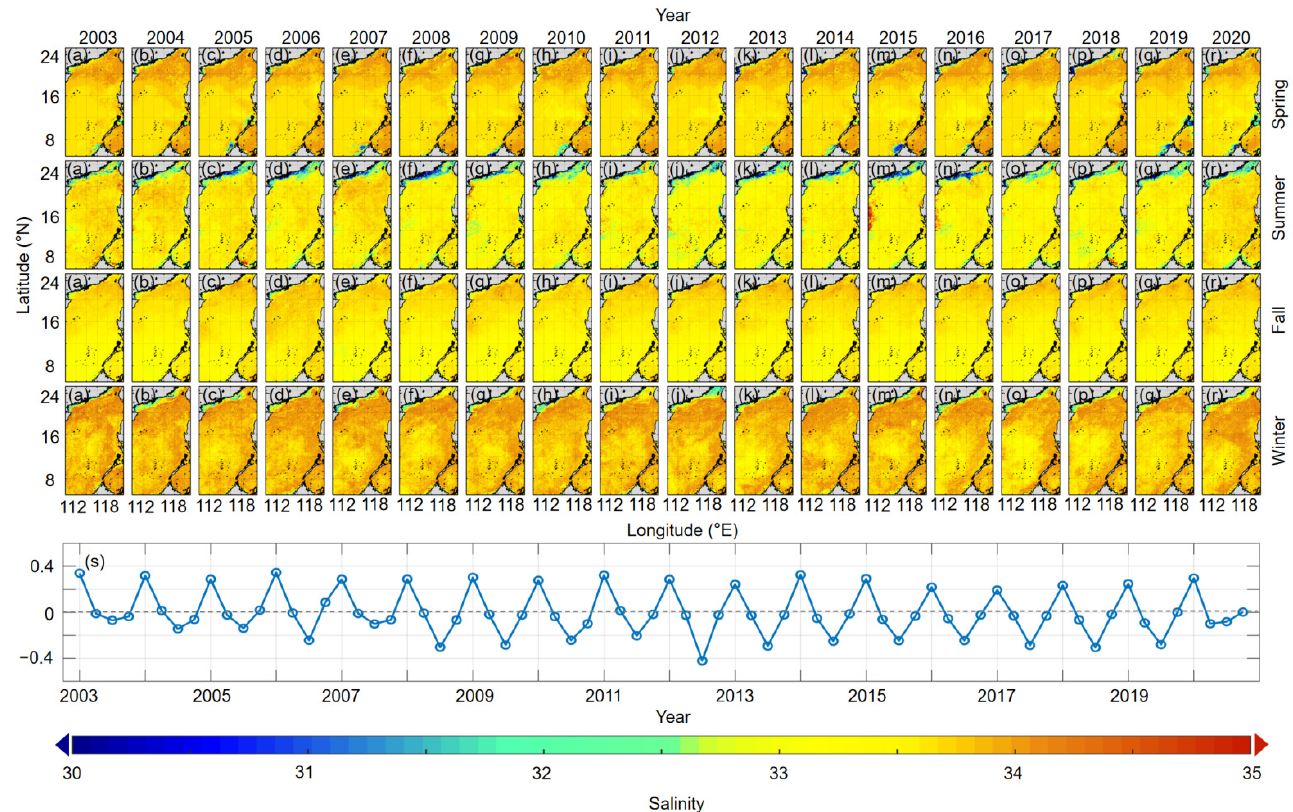
Figure 5. Reconstructed seasonal sea surface salinity (SSS) fields in the South China Sea during 2003–2020 ( a – r ) and seasonal anomalies of SSS during 2003–2020 ( s ). Climatological monthly and seasonal average SSS values were calculated based on the reconstructed monthly SSS over 2003–2020 (Figure 6). The spatial distribution of the climatological SSS is essentially consistent with that of the underway observations (Figure 4), especially in the areas influenced by the China Coastal Current in the winter and the Pearl River plume in the summer. The spatio-temporal distribution of the climatological fields is also consistent with the sea surface circulation (Figure 6). In the northern SCS, the reconstructed SSS fields are mainly influenced by the westward flow from the Luzon Strait and the Pearl River plume which begins to increase in September and peaks in February. As the winter monsoon begins to transition to the summer monsoon in the SCS, the westward flow from the Luzon Strait weakens, and the coast of the northern SCS is affected by an eastward flow that carries the Pearl River plume and lowers the SSS in this region. Thus, the influence of the Pearl River plume is greatest in July. Moreover, in summer, the Mekong River plume intensifies, and a northbound flow from the western SCS carries the Mekong River plume and bifurcates around 12 ◦ N, with one branch moving northward and the other flowing eastward [48]. The spatio-temporal changes of the low salinity area (SSS ≤ 33) in the western SCS are consistent with the extent of the eastward flow (Figure 6e–h), which represents the intensity of the Mekong River plume [48]. This consistency indicates that our reconstructed SSS in the western SCS relatively accurately represents the dynamic impact of the Mekong River plume in the